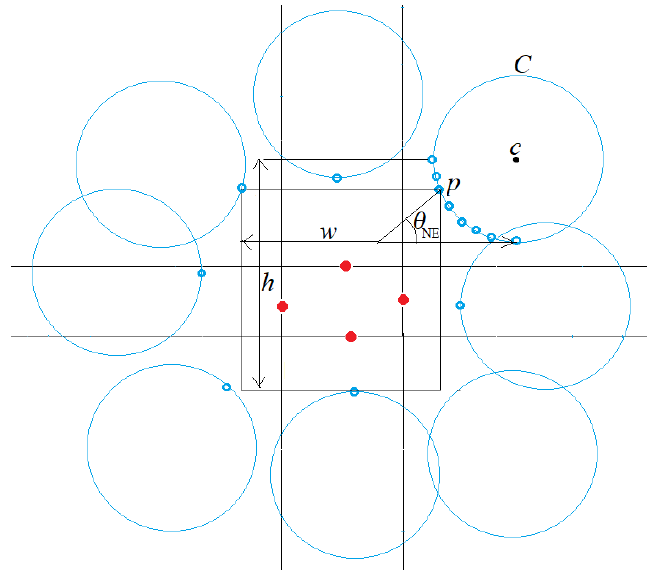
Figure 23. Area of the CSR cornered on circle C ( c ,1 ) as a function f NE ( θ NE ) of that corner’s location. Lemma 4. f NE has at most 3